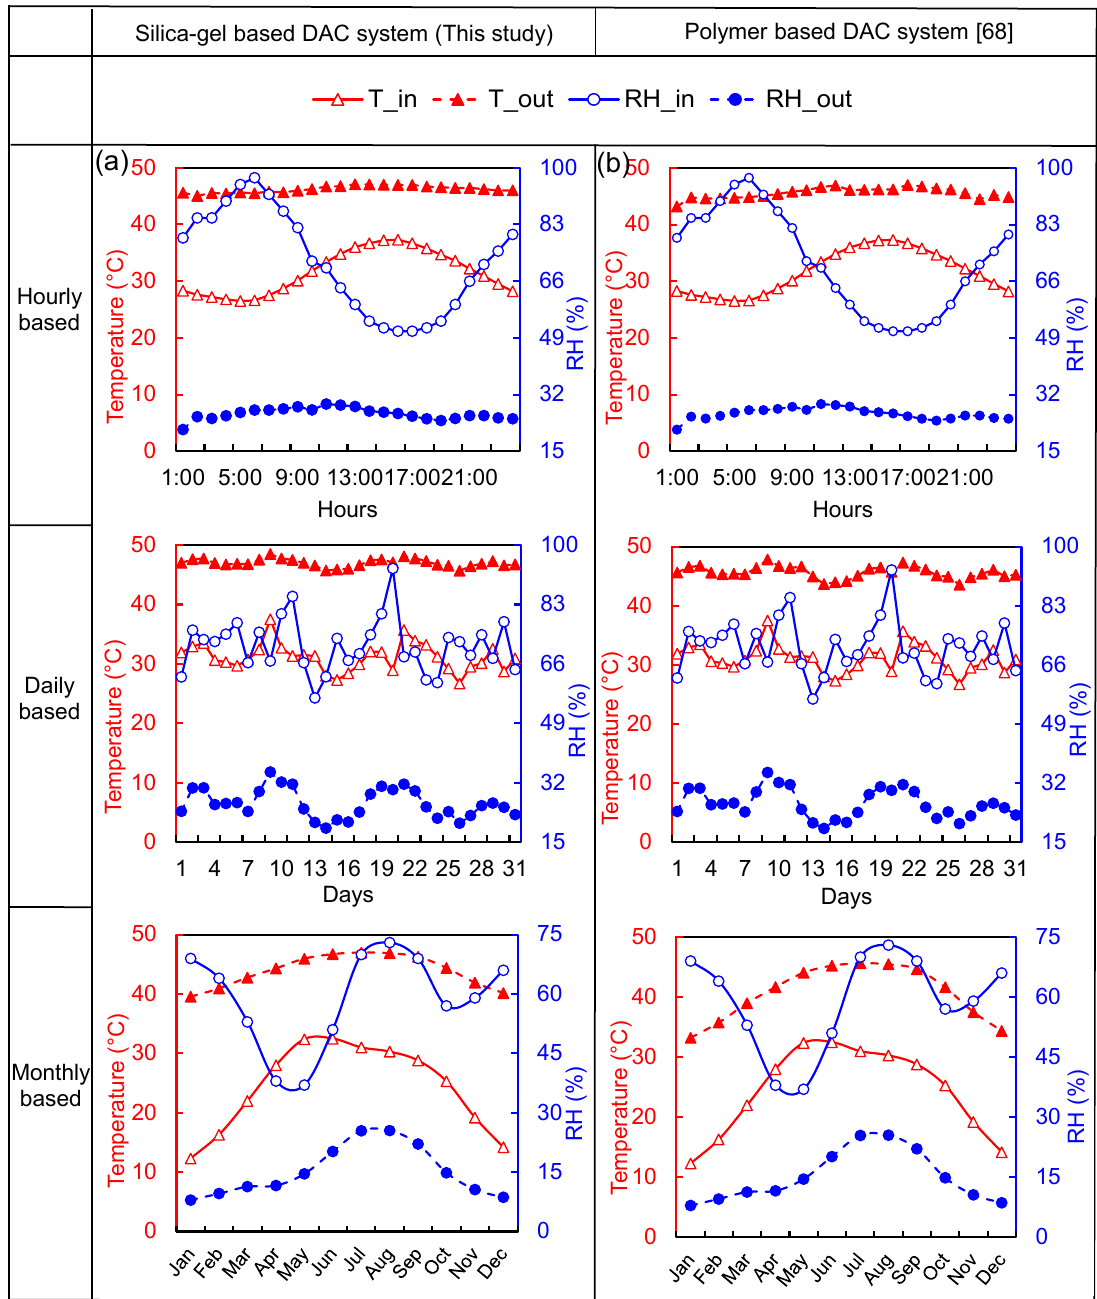
Figure 8. Thermodynamic performance of ( a ) silica-based standalone DAC system, and ( b ) polymer-based DAC system on an hourly, daily, and monthly basis for the climatic condition of Multan (Pakistan).